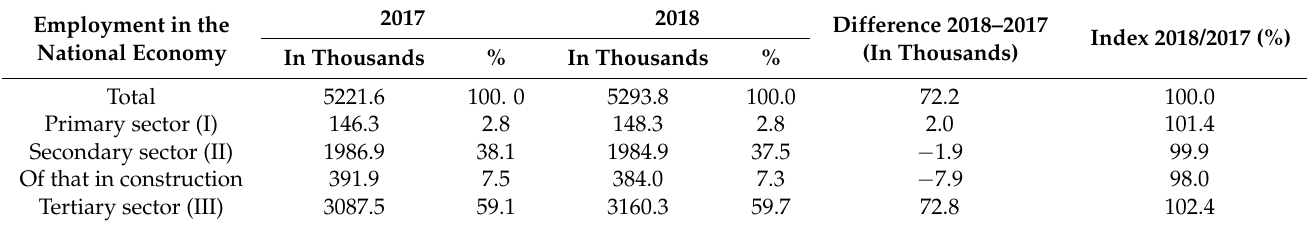
Table 1. Structure of employment in the period 2017–2018 by